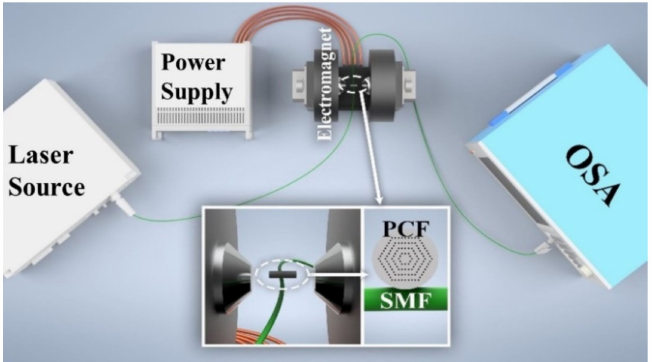
Figure 2. Schematic of experimental setup for investigating the sensing properties. SMF: single mode fiber, PCF: photonic crystal fiber, OSA: optical spectrum analyzer.